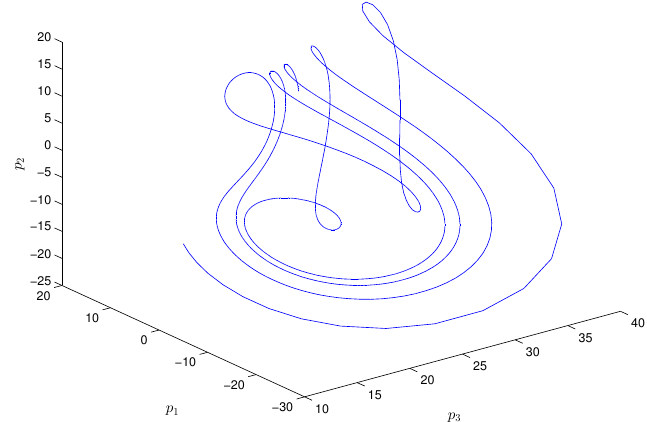
Figure 6. A 3D phase portrait of the Chen system